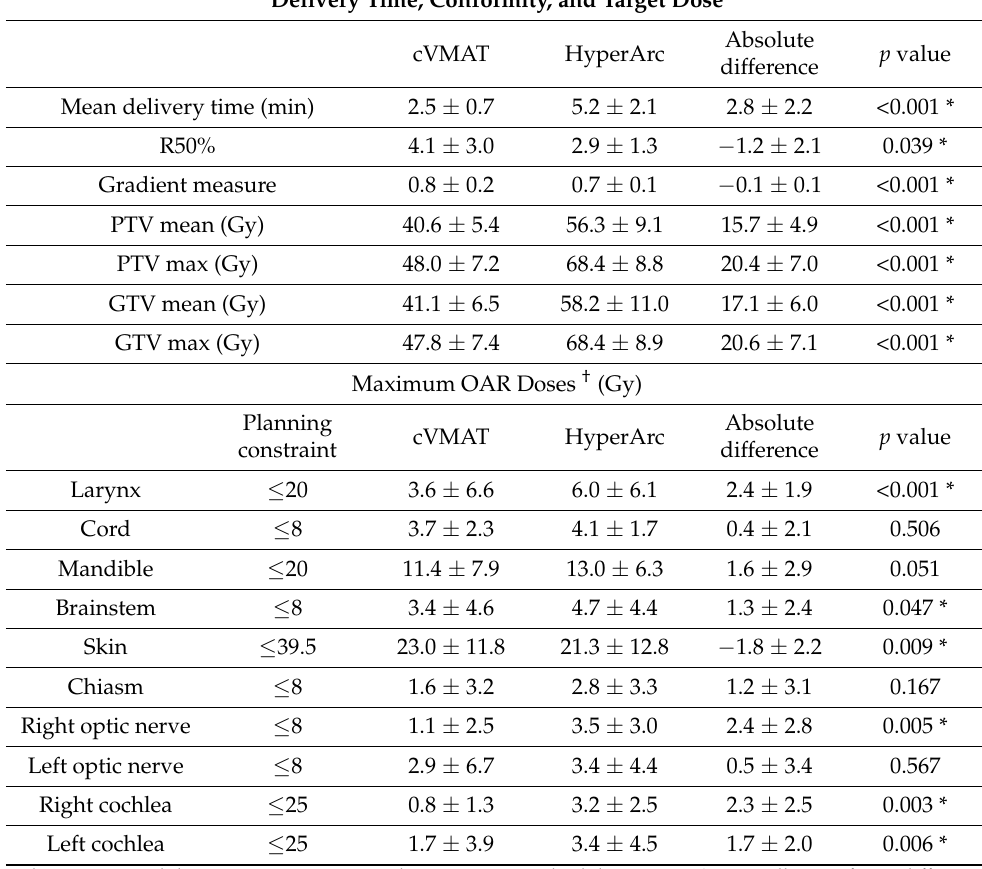
Table 2. Delivery time and dosimetric